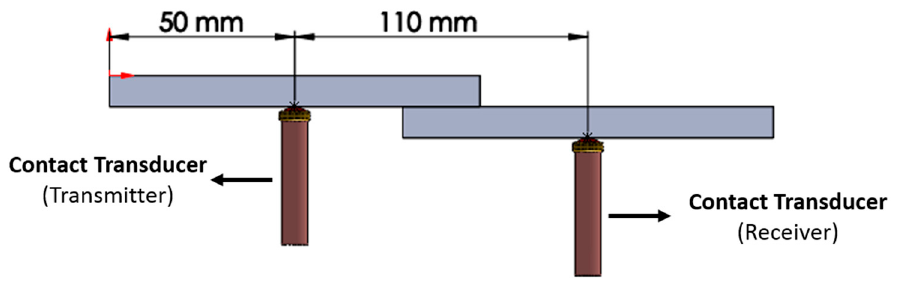
Figure 10. Guided wave arrangement with two contact ultrasonic transducers.